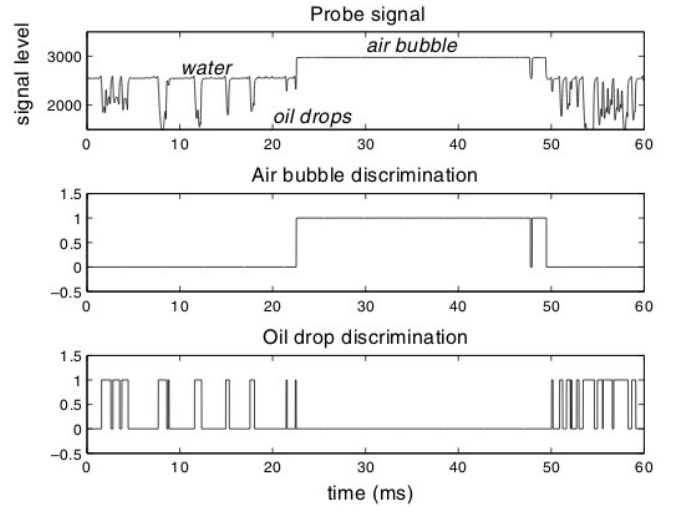
Figure 4. Probe detection and data processing for air bubbles in oil-in-water flow